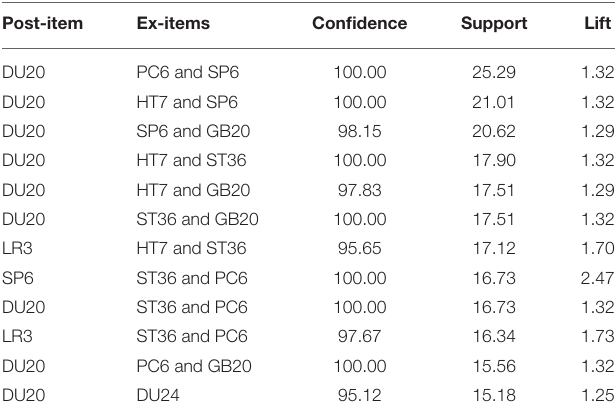
and Yin-tang (EX-HN3), with Stomach Meridian as the main meridian. When twitching of the limbs occurred, Jian-yu (LI15), Wai-guan (SJ5), and Feng-long (ST40) were often used, with Large Intestine Meridian as the main choice. Lian-quan (RN23) was often used when vocal tics were present. When mental symptoms were also present, Shen-men (HT7) and Nei-guan (PC6) were often selected. Tian-zhu (BL10), Ren-ying (ST9), and Lie-que (LU7) were often selected when neck tics